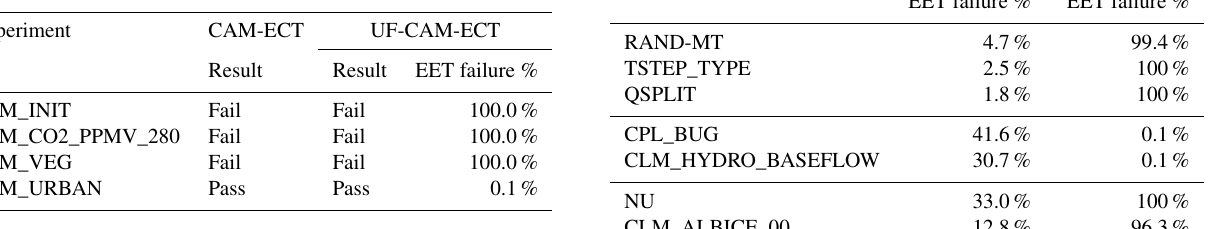
Table 2. These CLM experiments show agreement between CAM- ECT and UF-CAM-ECT as well as with the expected outcome. The CAM-ECT column is the result of a single ECT test on three runs. The UF-CAM-ECT column represents EET failure rates from 30 runs.